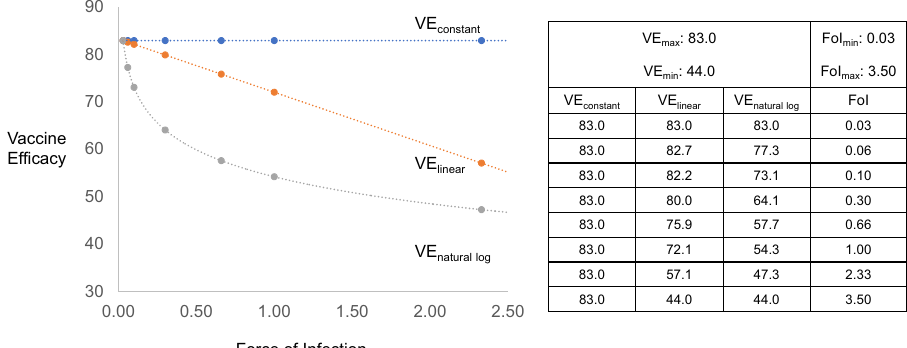
Fig. 1 Vaccine Ef fi cacy (VE) as a function of force of Infection (FoI) for hypothetical vaccine. Equations that de fi ne three mathematical scenarios (see Box 2, Vaccine ef fi cacy as a function of force of infection) are shown graphically, using as an example a hypothetical vaccine with a maximum vaccine ef fi cacy (VE max ) of 83.0% and minimum VE (VE min ) of 44.0% studied under conditions of force of infection (FoI) that vary across two orders of magnitude, from a minimum FoI (FoI min ) 0.03 to a maximum FoI (FoI max ) of 3.50 infections/